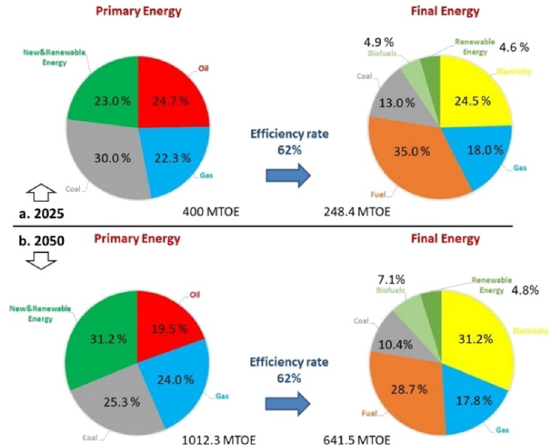
Fig. 1 The target of Indonesian energy mixed in 2025 ( a top) and 2050 ( b bottom) based on Presidential Regulation No. 22 of 2017. Coal is still the main primary energy until 2025 and 2050 to produce electricity as final energy up to 135.5 GW and 443.1 GW in 2025 and